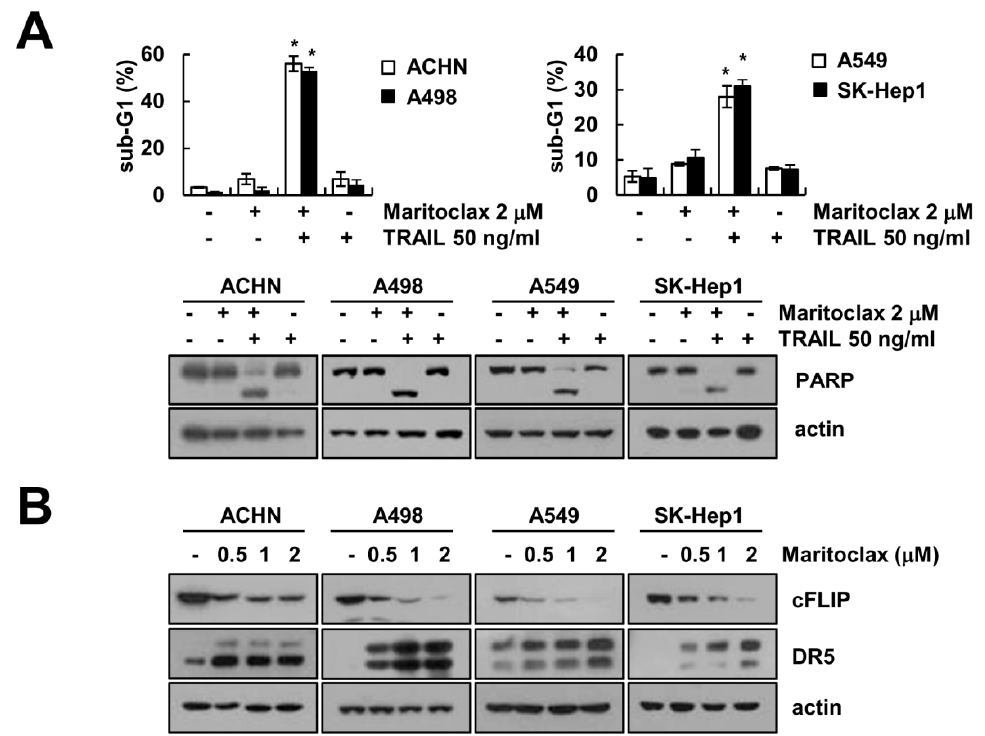
Figure 7. The effects of combined treatment with maritoclax and TRAIL on apoptosis in other carcinoma cells. ( A ) ACHN and A498 (renal carcinoma), A549 (lung carcinoma) and SK-Hep1 (hepatocellular carcinoma) cells were treated with 50 ng/mL TRAIL in the presence or absence of 2 µ M maritoclax for 24 h. The level of apoptosis was measured by the sub-G1 fraction using flow cytometry. The protein expression levels were determined by Western blotting. ( B ) Cells were treated with the indicated concentrations of maritoclax for 24 h. The protein expression levels were determined by Western blotting. − , no treatment; +, treatment. The values in graph ( A ) represent the mean ± SD from three independent samples. * p < 0.05 compared to the control by ANOVA and Student-Newman-Keuls methods.